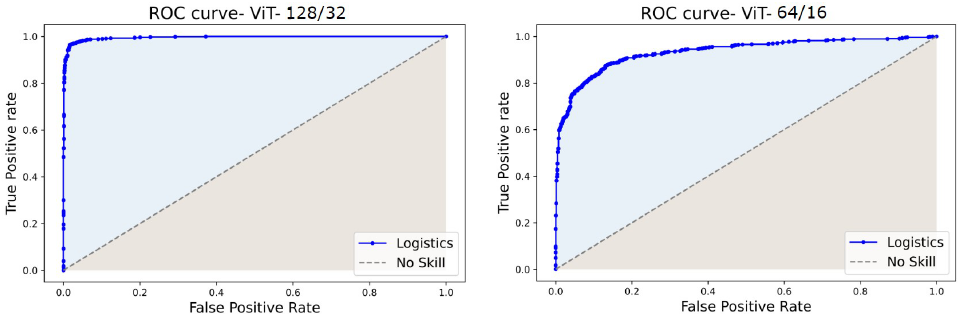
Figure 17. ROC curves of ViT128/32 and